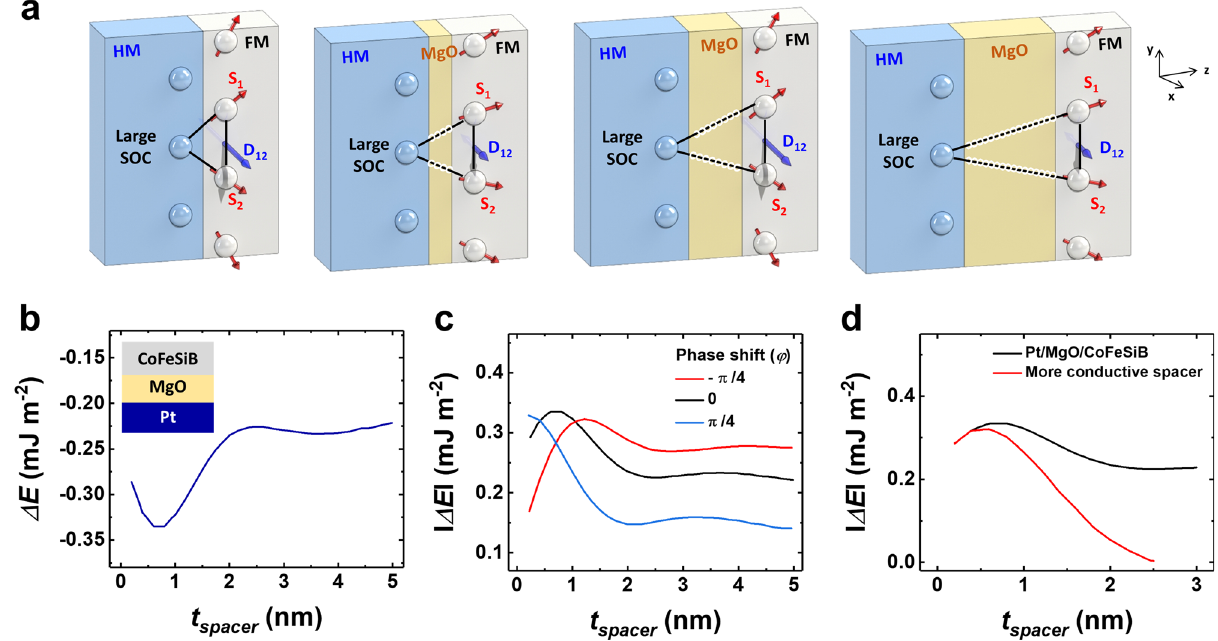
Fig. 4 Theoretical calculations of the energy difference between the spin-polarized and non-polarized electron energy entering the HM layer. a Scheme of an iDMI at the interface between the HM (blue) and FM (gray). The iDMI vector ( D 12 ) is related to the triangle composed of two magnetic sites and an atom with a large SOC. The scheme represents the oscillating magnitude of D 12 with corresponding spin tilting. b Energy difference (equal to the absolute value of the iDMI surface energy) calculated for the Pt/MgO/CoFeSiB system. c Shift of the oscillation-like behavior due to the assumption of a quantization condition Eq. (4) of k 3 ; 1 L 3 ; 1 þ k 3 ; 2 L 3 ; 2 þ k 3 ; 3 L 3 ; 3 þ ¼ ¼ 2 π q þ φ expressed in terms of the out-of-plane components of the circular wavenumbers k 3,n and thickness L 3,n of all three constituent layers ( n = 1, 2, 3). The black curve represents φ = 0 ˚ , while the red and blue curves represent φ = π /4 and φ = − π /4, respectively. The energy difference is displayed in terms of absolute value. d Theoretically calculated in fl uence of the spacer nature on iDMI, where the black and red curve represents the energy difference for our sample ( E F – E MgO = 9 × 10 − 21 J) and more conductive spacer sample ( E F – E conductive spacer = 12 × 10 − 21 J), respectively.